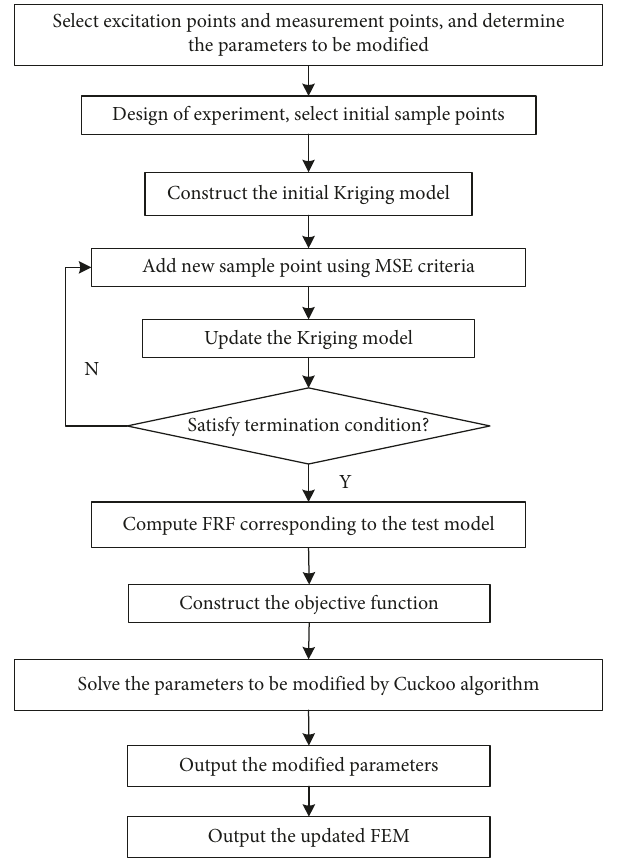
Figure 2: Flow chart of model updating.